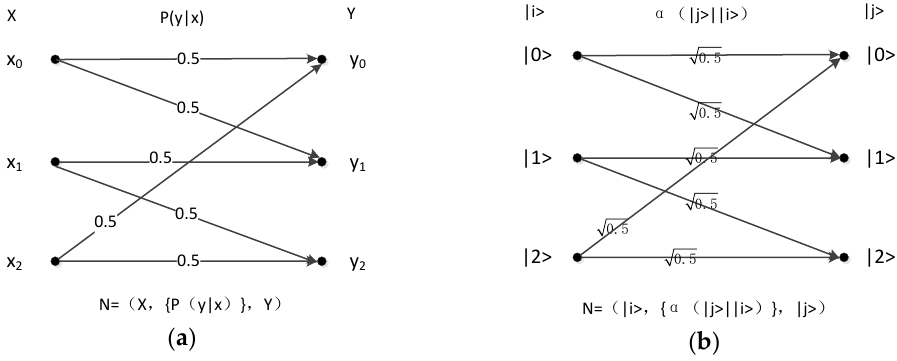
Figure 6. ( a ) Classical triangular channel; ( b ) quantum triangular coefficient channel.